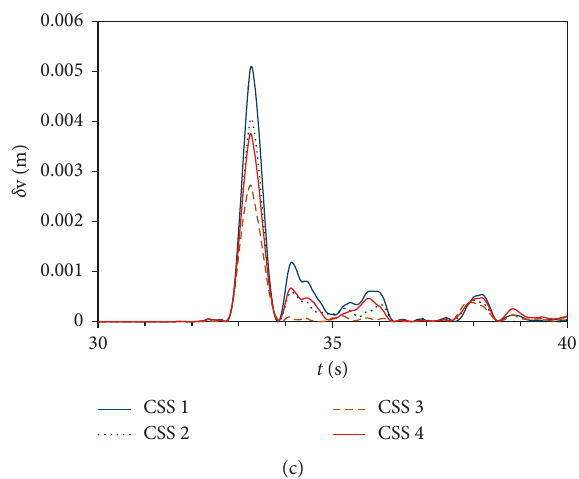
Figure 14: Four-column frame: vertical displacements with 3D input for (a) C0, (b) C3 with μ